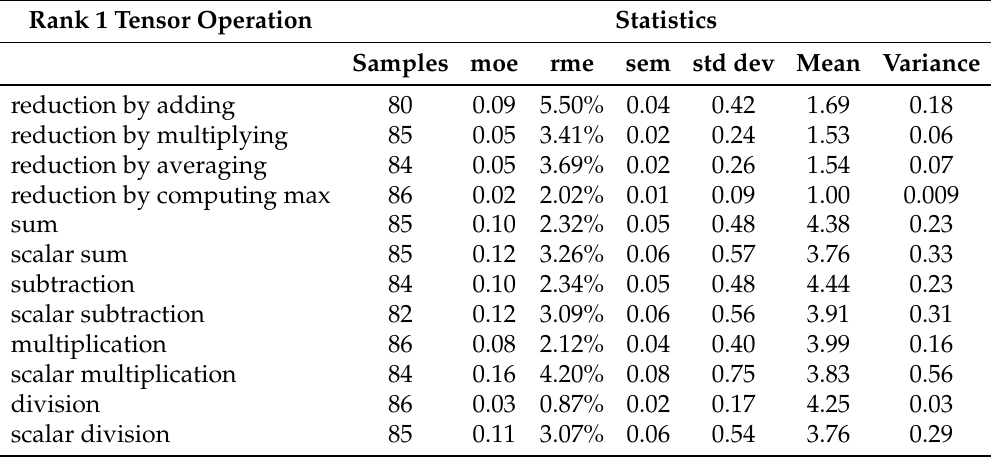
Table 9. Raspberry Pi III B+ benchmark statistics for rank 1 tensor operations with k = 64 (times in ms).